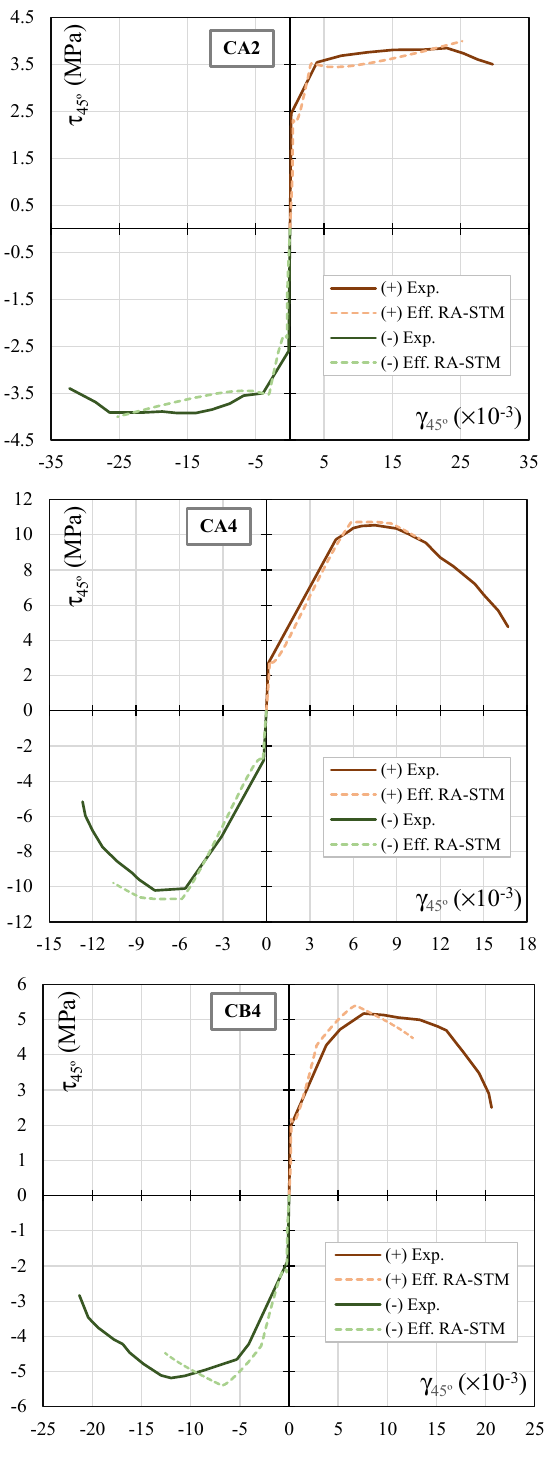
Figure 6. Envelope τ 45 ◦ – γ 45 ◦ curves for the reference RC panels (CA2, CA3, CA4, CB3, CB4 and τ γ − Figure 6. Envelope curves for the reference RC panels (CA2, CA3, CA4, CB3, CB4 and CD2). ° ° 45 45